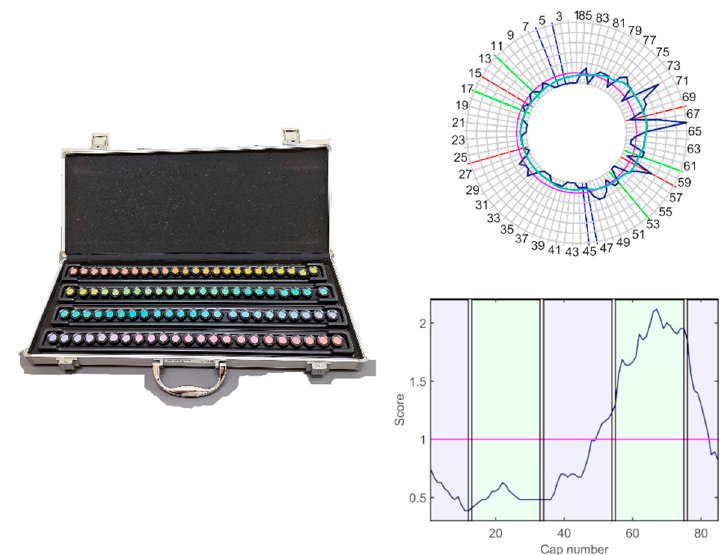
Figure 1. ( Left ) the Farnsworth–Munsell 100 hue test. ( Right ) example of the standard result diagram, showing the original Farnsworth plot ( top , blue line), its low-pass-filtered version ( top , cyan line), and the Dain–Birch (DB) plot ( bottom ). The coloured sections of the DB plot represent which caps are sorted according to RG (green) and BY (bluish) mechanisms. The magenta line is the patient’s normalised mean score. The example shows general discrimination losses that are worse for the red-green mechanism.